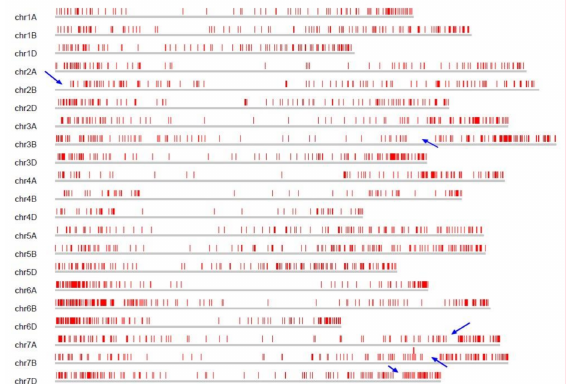
Figure 2. Chromosomal distribution of the TaFBX gene family on the bread wheat genome. Each red dash represents a TaFBX gene. Blue arrows highlight five chromosomal portions in the peripheral regions without any TaFBX genes, bordered by two regions rich in TaFBX genes.